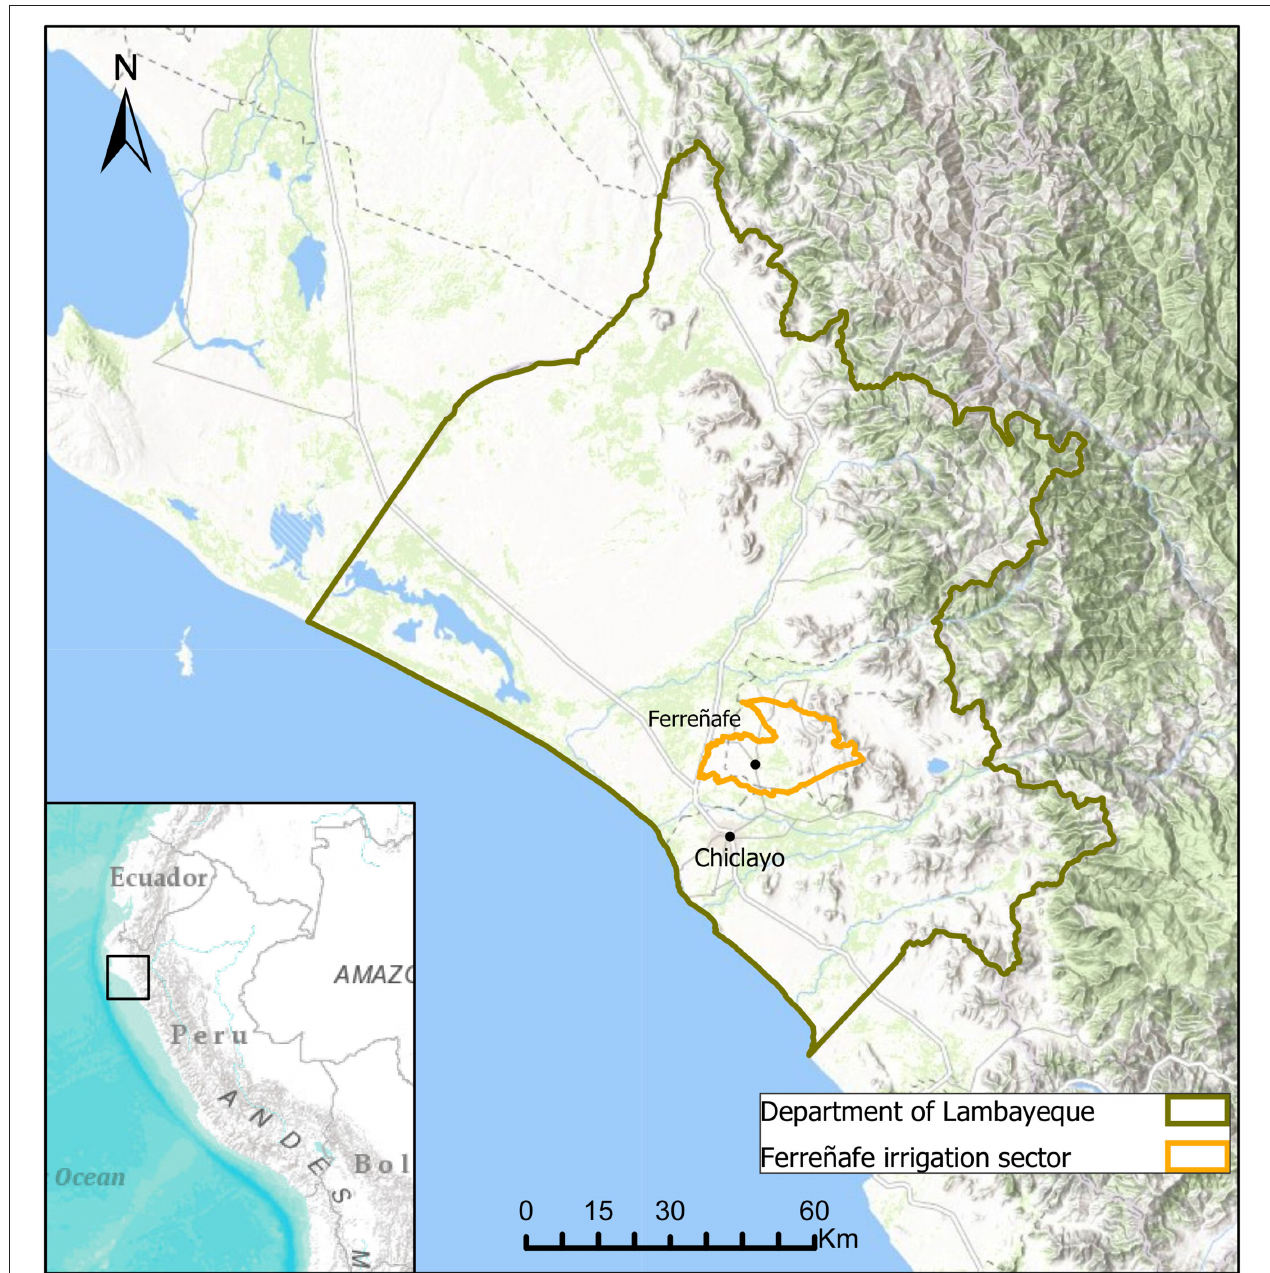
FIGURE 1 | Map showing the Ferreñafe irrigation sector in the department of Lambayeque, Peru. Surveys were completed in the Ferreñafe irrigation sector. Sources: Esri, DeLorme, HERE, TomTom, Intermap, increment P Corp., GEBCO, USGS, FAO, NPS, NRCAN, GeoBase, IGN, Kadaster NL, Ordnance Survey, Esri Japan, METI, Esri China (Hong Kong), swisstopo, MapmyIndia, and the GIS User Community.